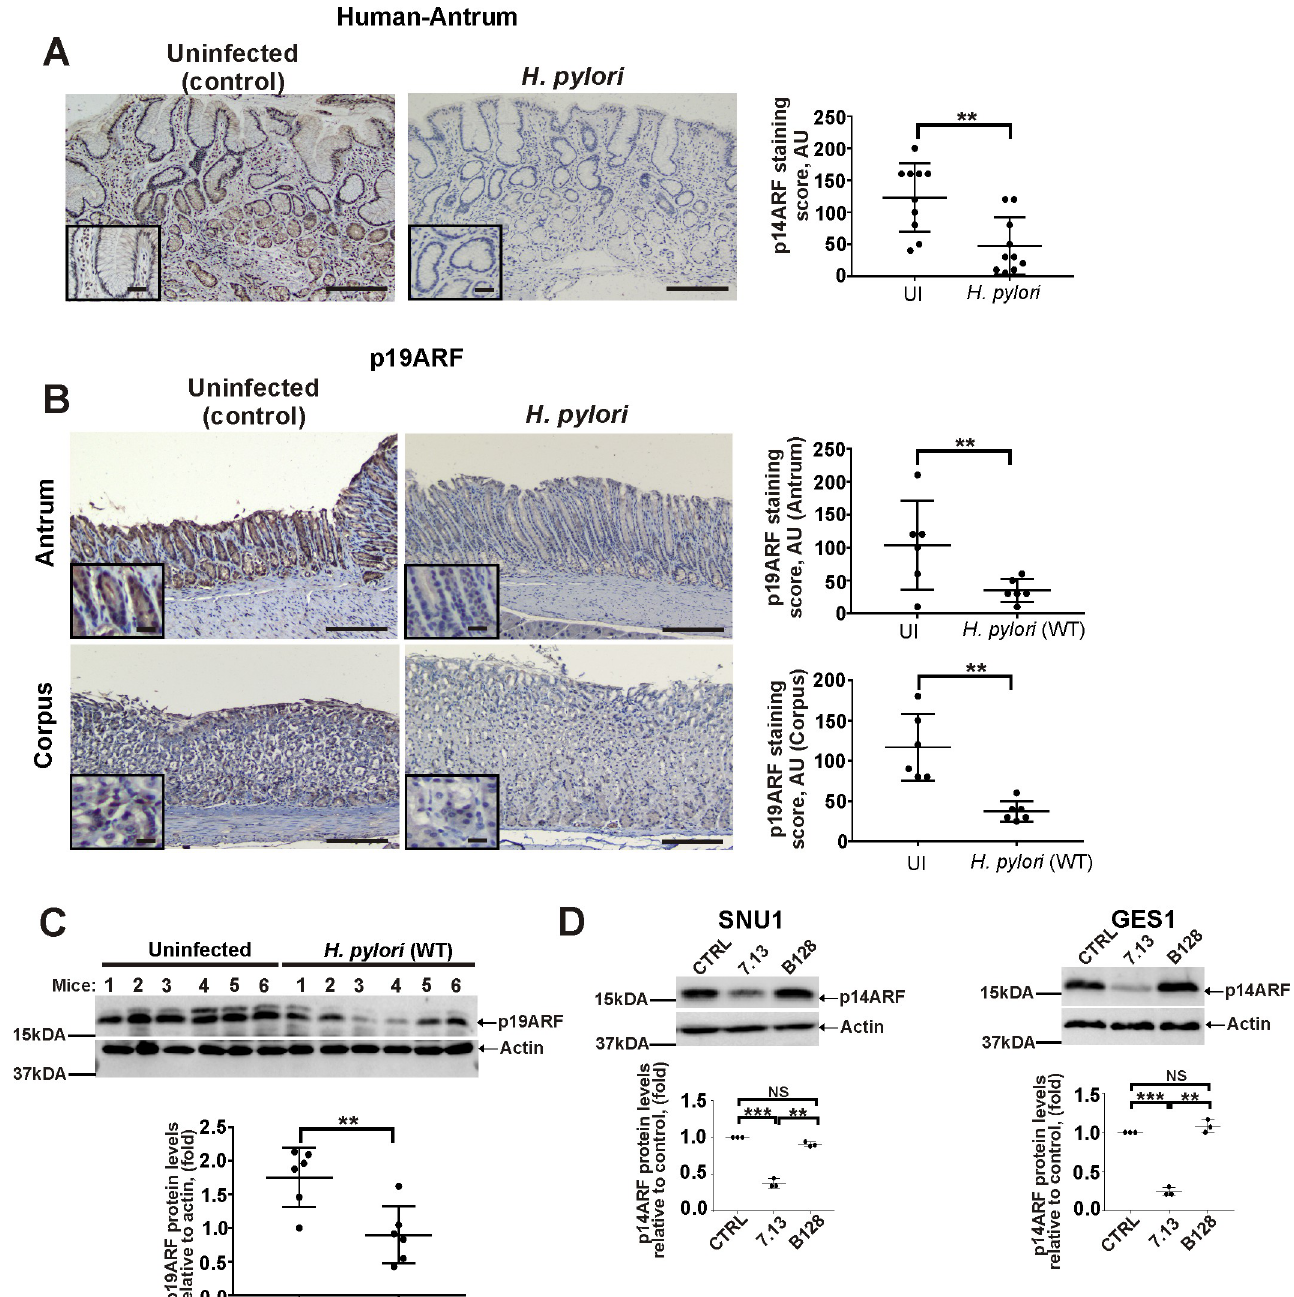
Fig 1. H . pylori infection leads to downregulation of p14ARF. (A) Representative images showing IHC staining for p14ARF protein in antral gastric biopsies collected from H . pylori -infected and non-infected patients with active chronic gastritis. The graph panel shows IHC scores for p14ARF (n = 10/group). (B) Representative images of IHC staining for p19ARF protein in the corpus and the antrum of H . pylori -infected and uninfected mice. The graph panel shows IHC scores for p19ARF (n = 6/group). (C) The same as (B), but gastric tissue homogenates from mice were analyze for p19ARF protein expression by Western blotting. Bottom panel shows the densitometric analysis of p19ARF protein expression. (D) Analysis of p14ARF protein expression in SNU1 and GES1 cells co- cultured with H . pylori strains 7.13 or B128 for 6hrs. The graph panels represent densitometric analyses of p14ARF protein expression. Expression of p14ARF protein in uninfected cells was arbitrarily set at 1. Data in A, B, and C were analyzed using unpaired 2-tailed t-test; data in D were analyzed using 1-way ANOVA followed by Tukey’s multiple comparison test. Data are displayed as mean ± SD (n = 3). Insets in (A) and (B) show the magnified views ( × 40). Scale bars: 50 μ m.